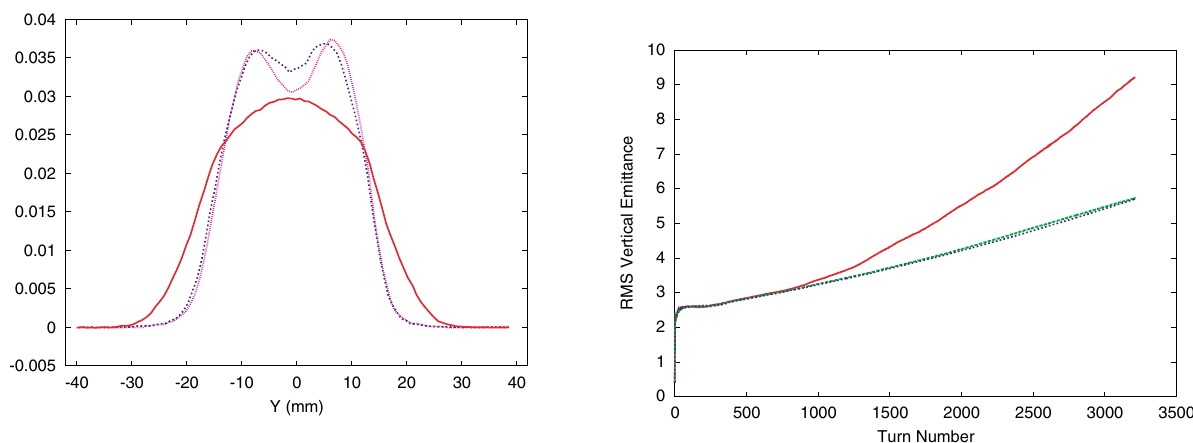
FIG. 4. (Color) Vertical rms emittance (in units of (cid:11) mm mrad ) evolution of the full intensity beam (solid red curve), the half intensity beam (dashed green line), and the quarter intensity beam (dotted blue line), obtained from PIC simulations.